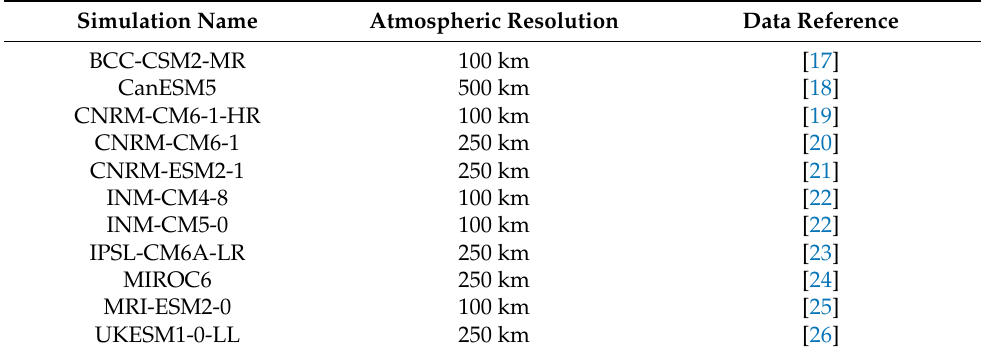
Table 1. List of CMIP6 simulations used in this study, their approximate horizontal resolution and